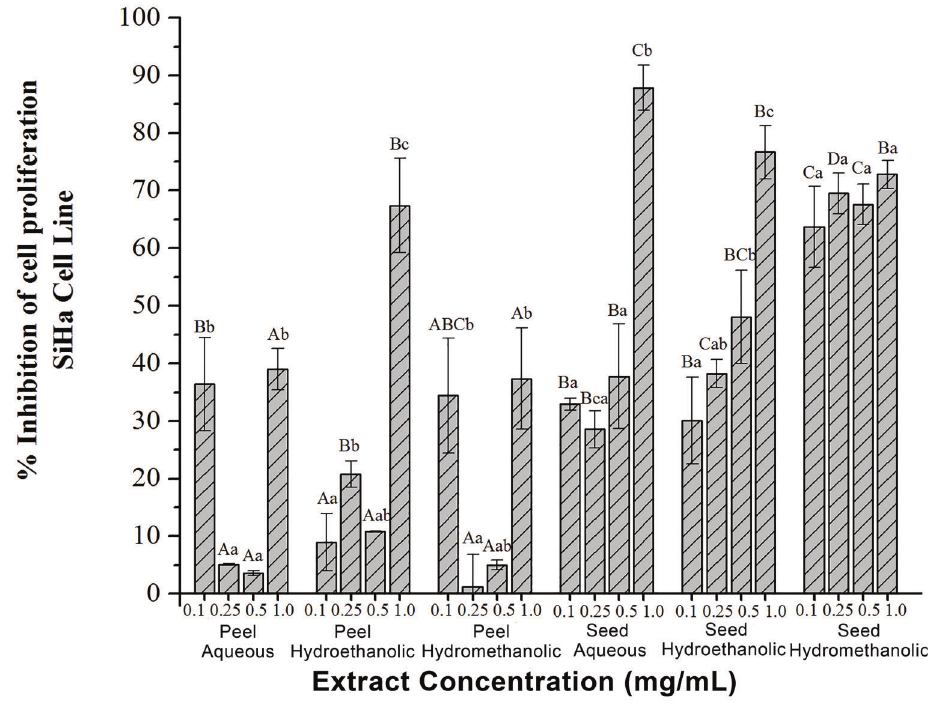
Figure 5. Effect of extracts of melon residues on the inhibition of cell proliferation of the SiHa cell line, measured by MTT test. Cells proliferation was carried out in the presence of melon residues extracts in different concentrations for 24 h. a,b,c,d Signi fi cant differences between different concentrations of the same sample. A,B,C,D Signi fi cant differences between different extracts in the same concentration (P o 0.05, ANOVA). Data are reported as means ±